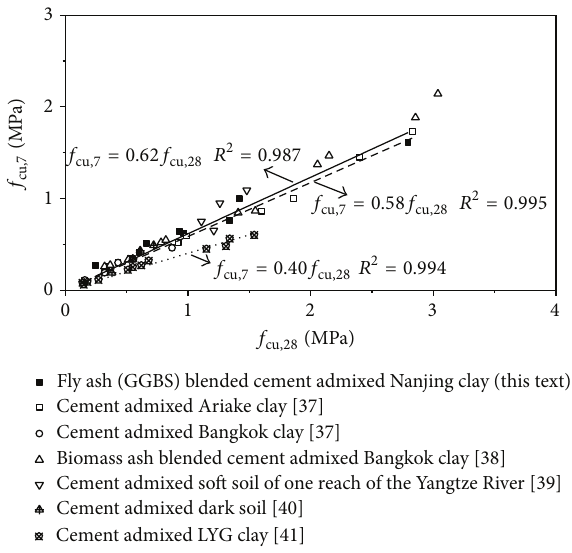
Figure 2: 𝑓 versus 𝑓 plot for different cement-treated clays. cu ,7 cu ,28